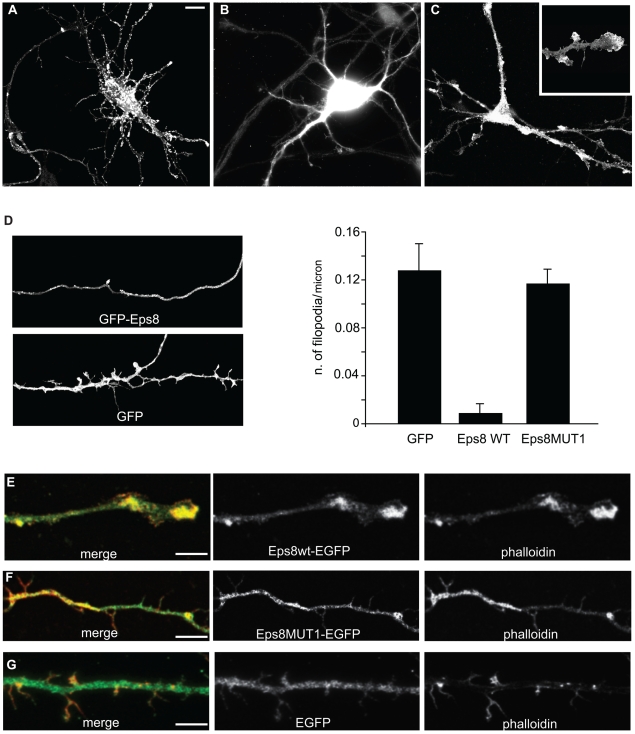
The regulation of filopodia density depends on Eps8 actin barbed-end capping activity.(A–D) Primary eps8
−
/− hippocampal neurons (3DIV) were infected with either WT Eps8-EGFP (A and C) or control EGFP (B) lentiviral vectors, then fixed and processed for epifluorescence. Neurons expressing Eps8 ([D] left top panel), but not those expressing EGFP ([D] left bottom panel), show a reduction in the density of axonal filopodia ([D] right panel; number of examined neurons: 120 Eps8wt-EGFP, 55 EGFP; Kruskal-Wallis one-way analysis of variance, p<0.001) Data are expressed as the mean±SEM. Of note, occasionally high levels of ectopically expressed Eps8 induced the presence of flattened structures, sometimes with club-like endings, ([C] and inset in [E]). (E–G) Primary eps8
−
/− hippocampal neurons (3DIV) infected with either Eps8wt-EGFP (E) or Eps8MUT1-EGFP (number of examined neurons: 31 [F]), an Eps8 mutant devoid of actin-capping activity (Figure S3), or control EGFP (G) lentiviral vectors were fixed and processed for epifluorescence or stained with Texas Red phalloidin, as indicated. Merged images are also shown. Eps8MUT1 neurons do not display flattened membrane protrusions and are morphologically undistinguishable from EGFP-infected neurons (see also quantitation [D], right panel). Bar indicates 10 µm for (A, B, and C); 3 µm for the inset in (C), 5 µm for (D), and 8 µm for (E and G).